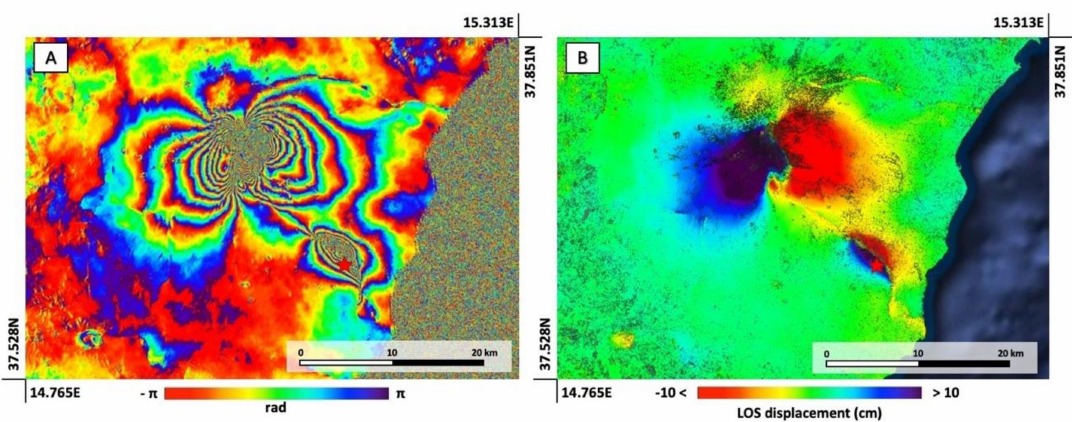
Figure 5. Sentinel-1 results relevant to the 26 December 2018 Mt. Etna (Italy) seismic event. ( A ) Coseismic interferogram produced from S1 ascending images (Track 44) spanning the time interval 22 December 2018–28 December 2018. ( B ) Coseismic displacement map related to the interferogram reported in ( A ). The red star identifies the epicenter location of the seismic event.